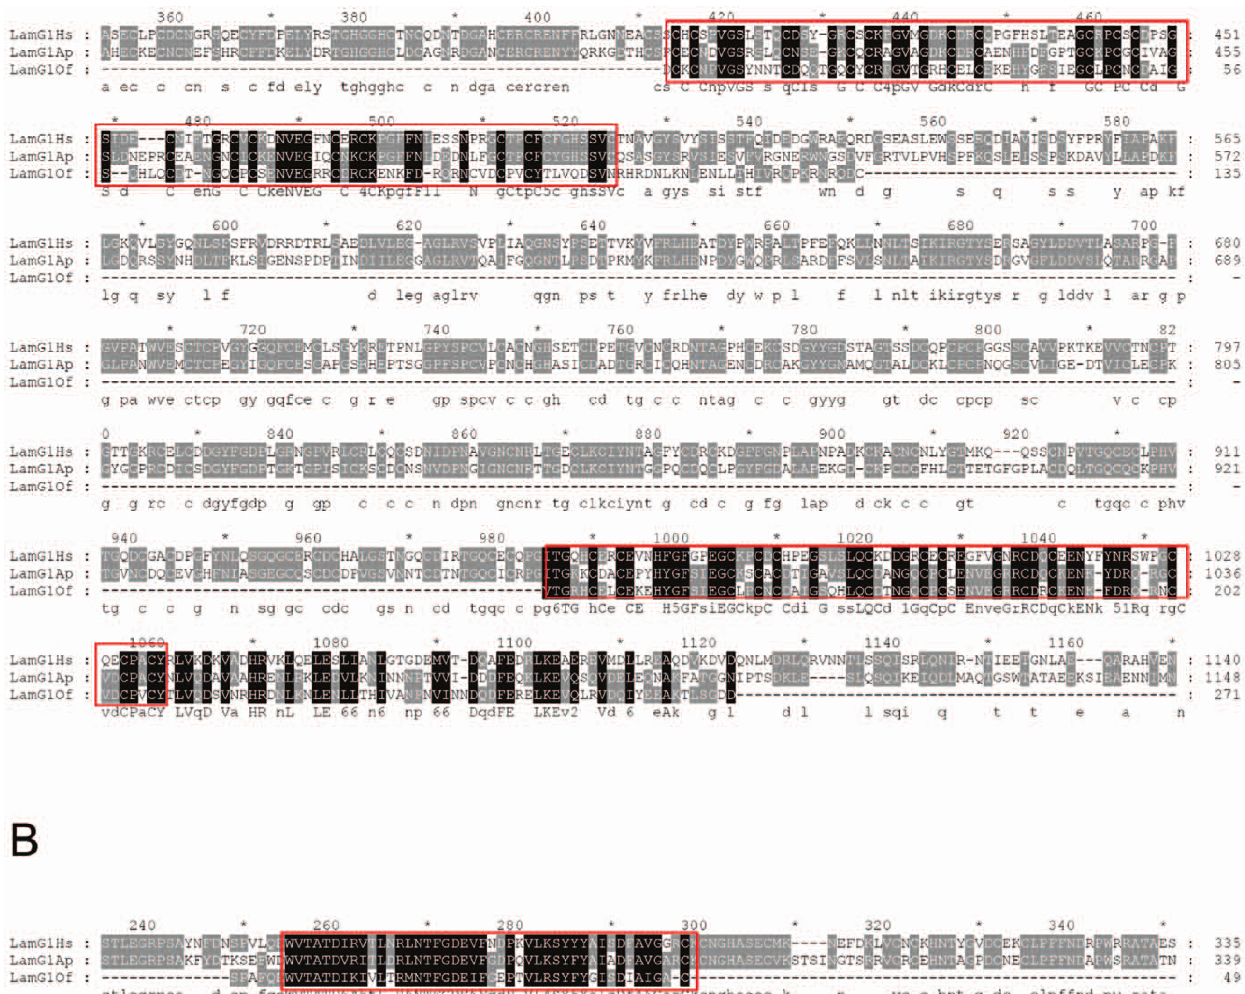
Figure 7. Comparison of laminin subunit c through pairwise alignment of c 1 of Homosapiens (LamG1Hs, gi|145309326), c 1-like of the hemipteran Acyrtosiphonpisum (LamG1Ap, gi|328717115) and c 1-like of O.fasciatus (LamG1Of). ( A ) The alignment shows two regions with highly conserved amino acids, consistent with the patterns found in EGF-like domains of c 1 subunits (highlighted in the red rectangles). ( B ) The alignment of the three c 1 subunits also reveals a sequence similar to the domain VI of c 1 of O. fasciatus transcriptome [28]. The region similar to domain VI is highlighted in the red rectangles in the alignment. Both in ( A ) and ( B ) black shaded residues are identical or similar amino acids present in all three sequences. Grey shaded residues are identical or similar amino acids present in two of the three sequences. The consensus sequence is represented under alignment lines. The alignments were performed using GENEDOC software [90].